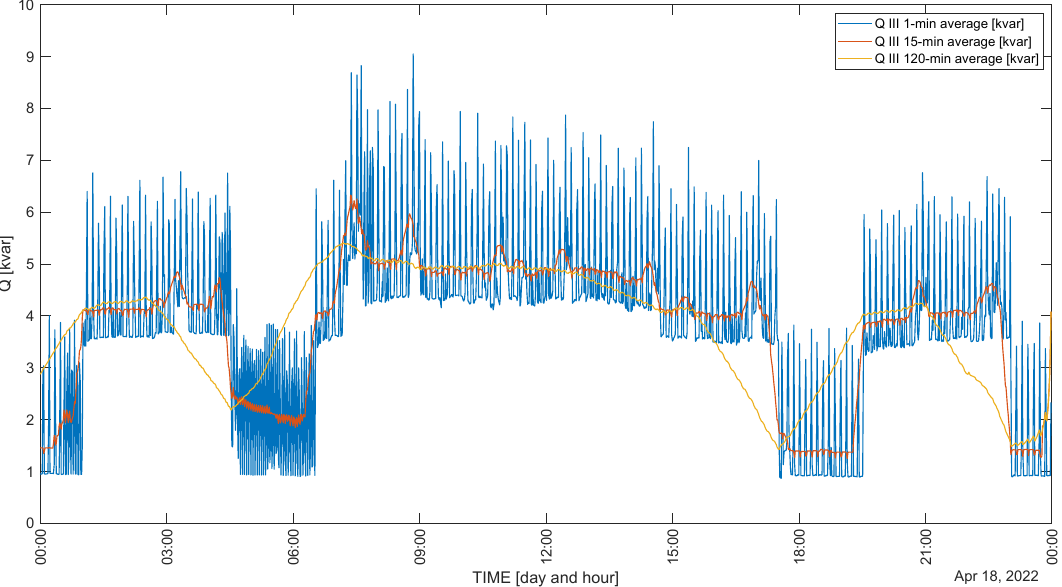
Figure 12. Three-phase reactive power as a function of time on a representative day of the 1st stage.